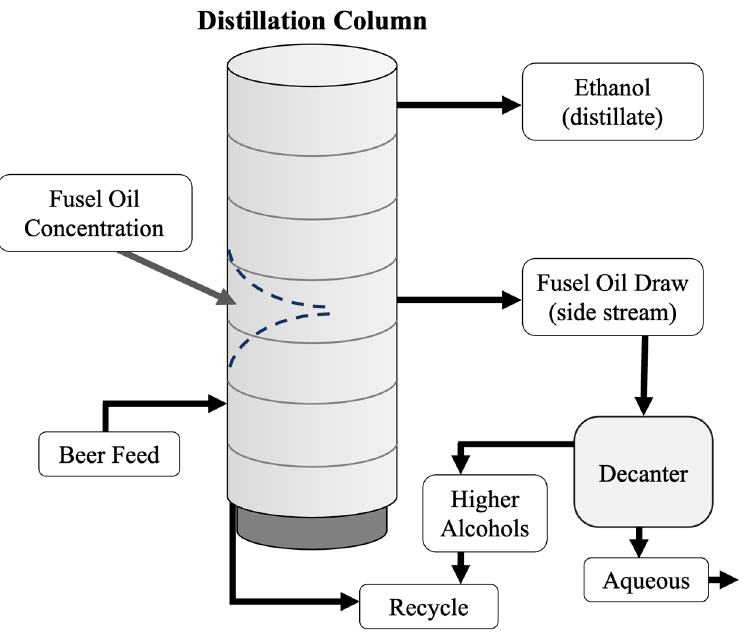
Figure 4. Distillation column with a fusel alcohol draw near the middle of the column. The fusel alcohols can be removed from the distillation process and decanted, reusing the higher alcohols and removing the aqueous phase. Without a fusel alcohol draw, the fusel alcohols will fall in the column and form a two-phase system. This can interfere with the distillation efficiency.